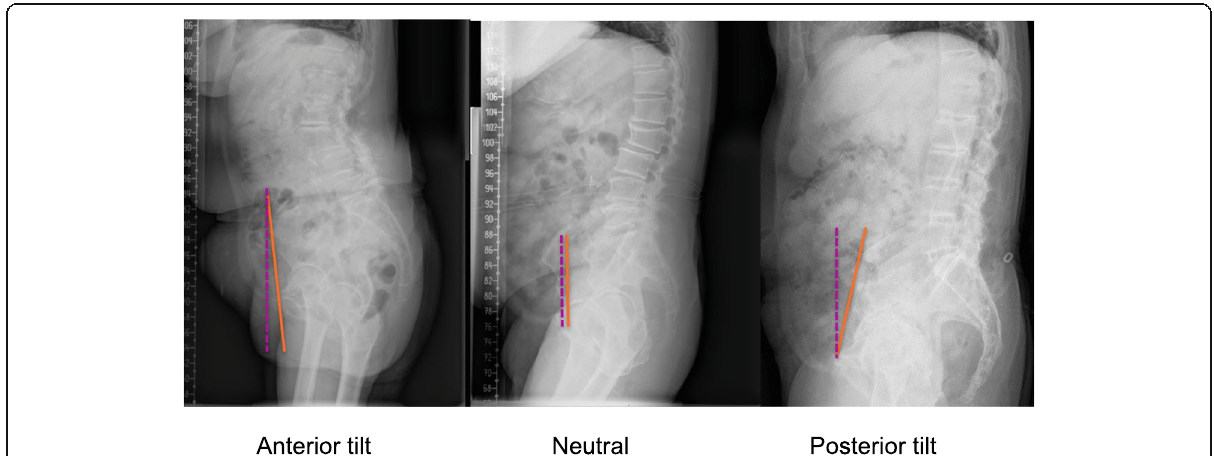
Fig. 1 The SPT angle, which is the angle between the vertical line (purple dotted line) and the line connecting the pubic symphysis and the center of the anterior superior iliac spine (orange line) in the standing position, was divided to three categories: anterior tilt (positive value), neutral (zero degree), and posterior tilt (negative value)